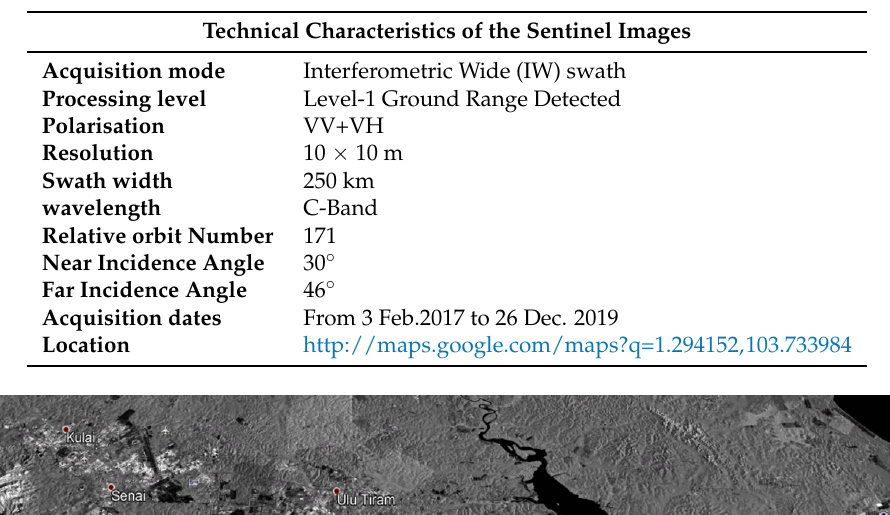
Table 3. Sentinel 1 data acquisition characteristics used for the study.